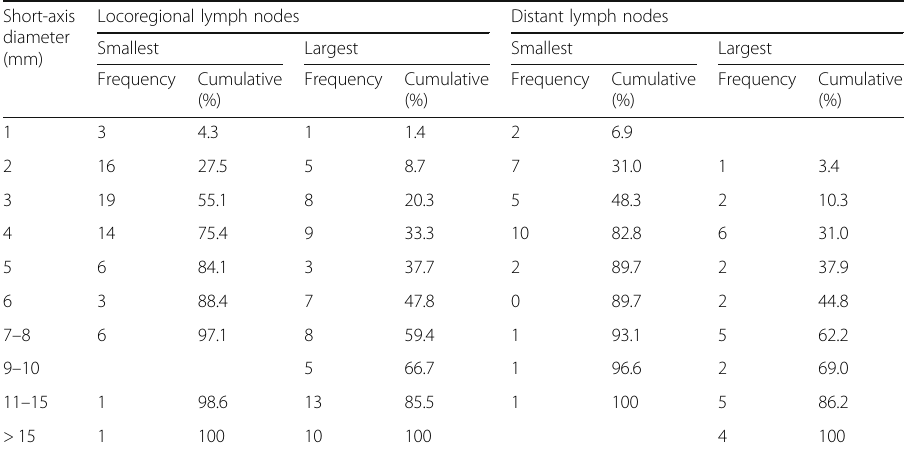
Table 2 Frequency table showing short-axis diameter of smallest and largest 18 F-DCFPyL positive lymph nodes in the pelvis and outside the pelvis on a per patient basis Short-axis